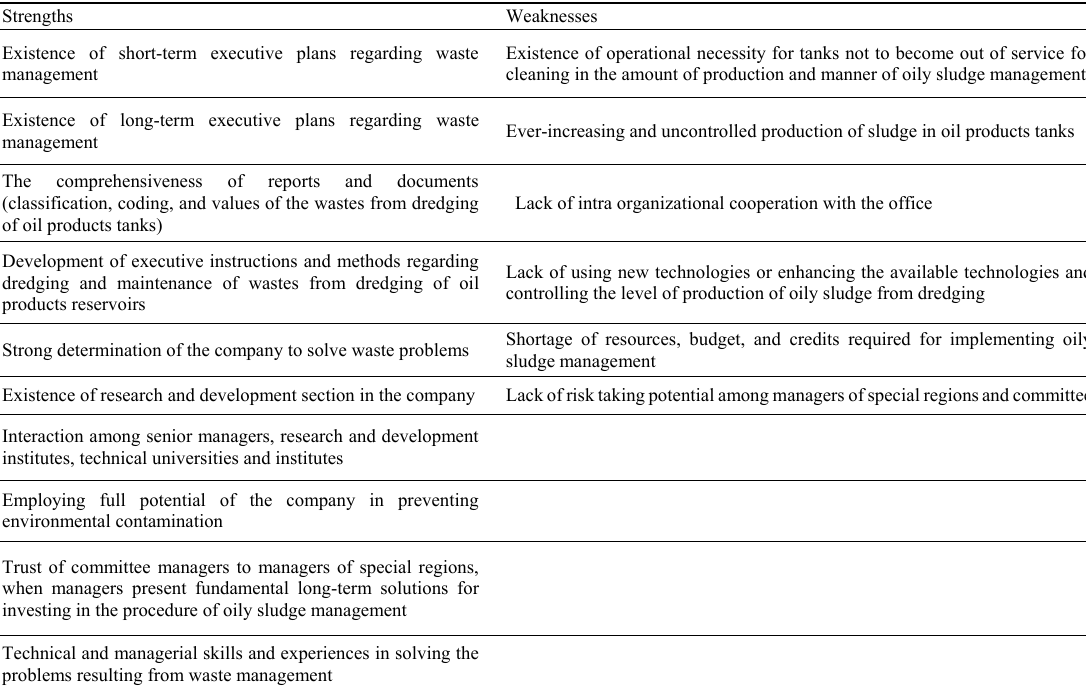
Table 2: Matrix of evaluation of internal factors